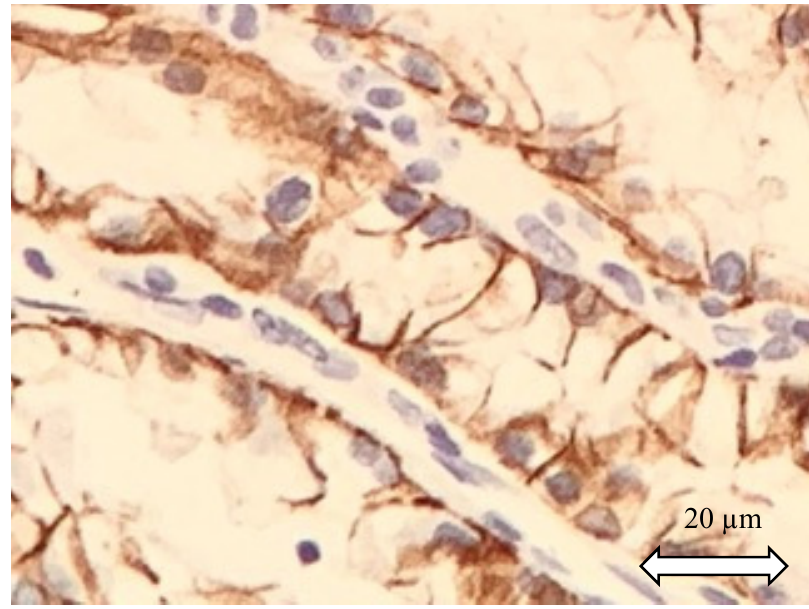
Figure 3. Clear cell papillary renal cell carcinoma. Cells display CA IX positivity with cup-like distribution.